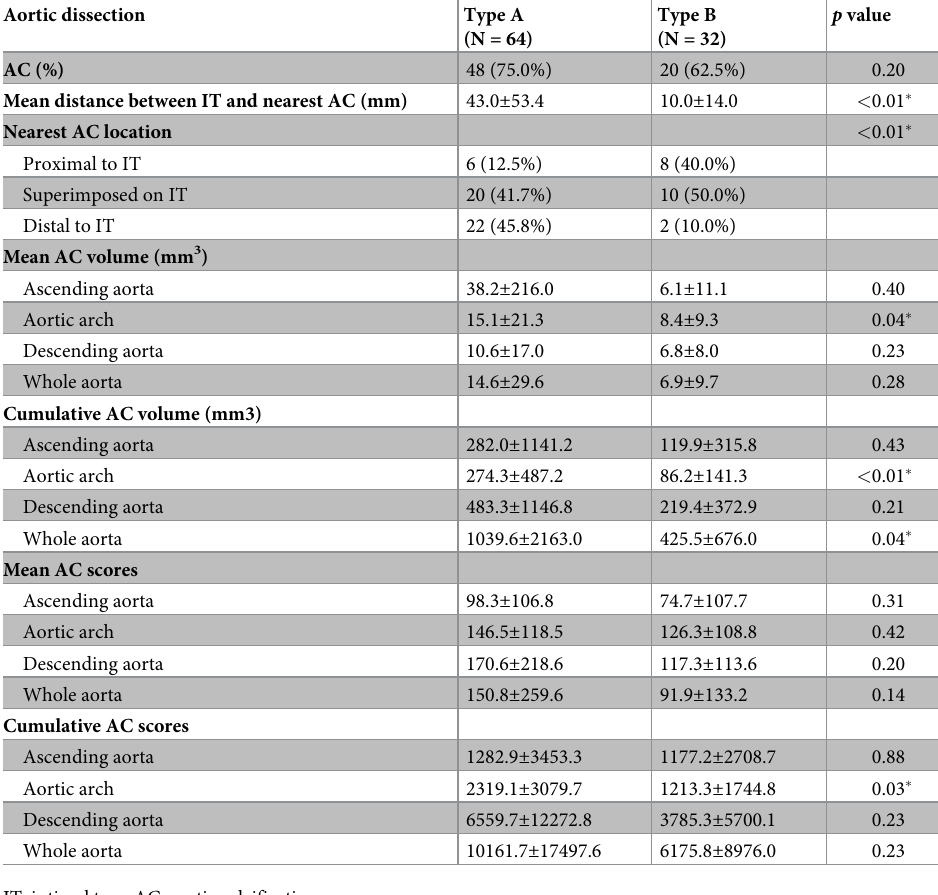
Table 4. Comparison between patients with type A and type B acute aortic